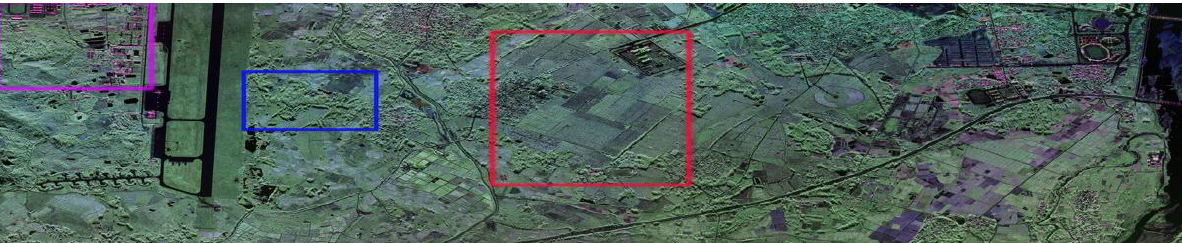
Figure.1.The colors ynthetized map of three polarizations basis (HH, HV, VV) of the LingShui area. The three test areas represented as red, blue and fuchsine color rectangles respectively.